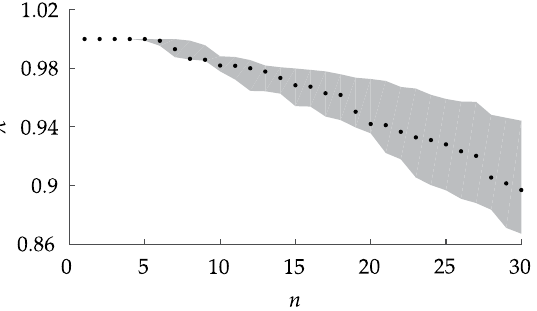
Figure 5. First 30 eigenvalues of the transition matrix P computed using two-day-long drifter trajectory data (dots) and uncertainties (gray shade) representing the total variation across eigenvalues computed from an ensemble of P s produced by randomly perturbing the trajectories. Computations and visualization carried using Matlab R2017a